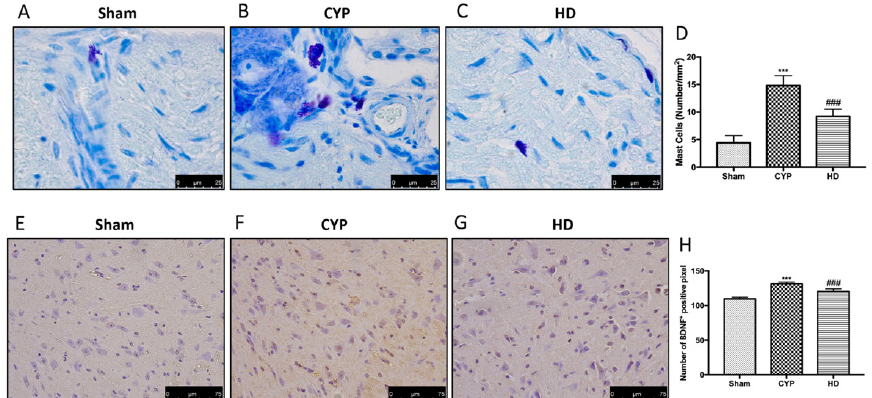
Figure 6. Effect of HD on MC activation and brain-derived neurotrophic factor (BDNF) expression in the spinal cord after repeated CYP injections . Mast cell infiltration was evaluated by toluidine blue staining in the chronic cystitis model. Mast cells were characterized by their dark-lilac-blue granules. ( A ) Sham group. ( B ) CYP group. ( C ) HD group. ( D ) Mast cell numbers per unit area of tissue (mast cell density). Immunohistochemical analysis showed a significant increase in BDNF-positive cells ( F , H ) compared to Sham mice ( E , H ). Animals treated with HD revealed a decrease in the expression of BDNF ( G , H ). Values are means ± SD of five animals for each group; *** p < 0.001 vs. Sham; ### p < 0.001 vs. CYP. In addition, significant positive staining of GFAP and Iba-1 was observed in the spi- nal cord of the CYP group mice (Figure 7B,F and 7D,H, respectively), compared to the control mice (Figure 7A,E and 7D,H, respectively). Treatment with HD decreased the ac- tivation of both astrocytes and microglia (Figure 7C,G and 7D,H, respectively). Lastly, through Western blot analysis, we demonstrated that repeated CYP injections induced the release of IL-1 β and TNF- α , whereas, in the Sham group, the levels of these inflammatory cytokines were low. Treatment with HD significantly prevented the release of IL-1 β and TNF- α (Figure 7I,J and 7I’,J’, respectively).